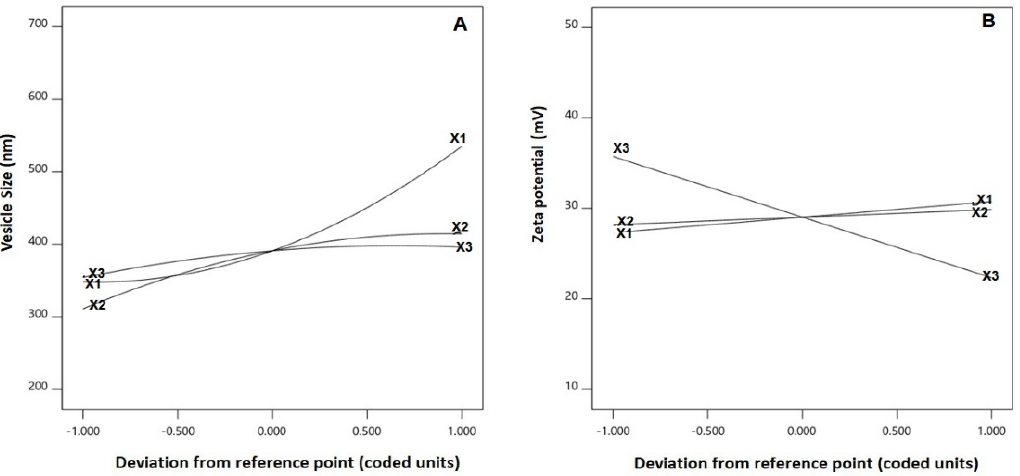
Figure 3. Perturbation graph for the main effects of critical attributes; PC: CH molar ratio (X 1 ), PC: TS weight ratio (X 2 ) and APA molar concentration (X 3 ) on ( A ) vesicle size and ( B ) zeta potential of EGA- EML-APA. Abbreviations: EGA, ellagic acid; EML, emulsomes; APA, apamin; PC: Phospholipon 90 G; Cholesterol: CH; TS;